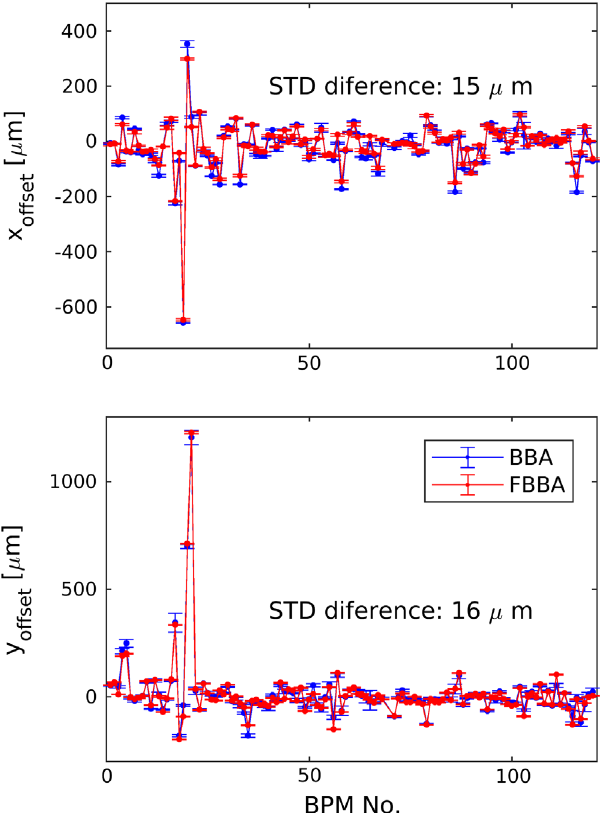
FIG. 13. Standard BBA and FBBA measurements for the 120 ALBA BPMs. The upper plot shows the results for the horizontal plane while the lower plot refers to the vertical plane. The results exciting the OCMs in ac are shown in red while the dc case result is shown in blue.